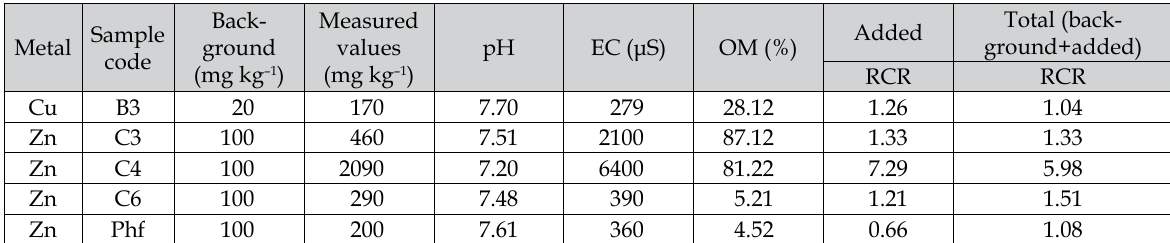
Table 3. The predicted ecological Risk Characterisation Ratio of metal in soils (EC – electrical conductivity; OM – organic matter). Sample Metal code